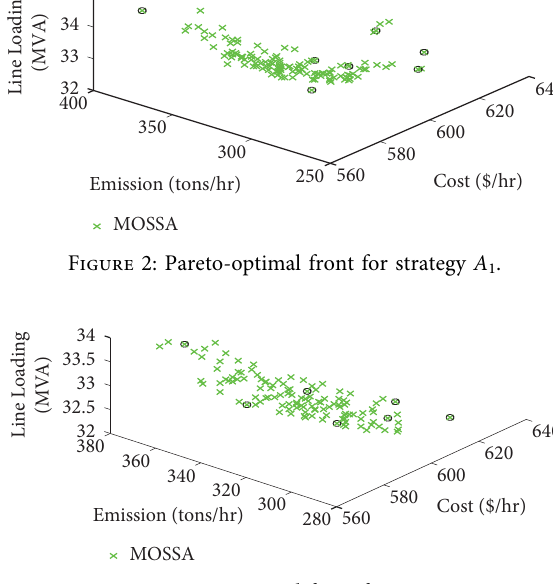
Figure 3: Pareto-optimal front for strategy A